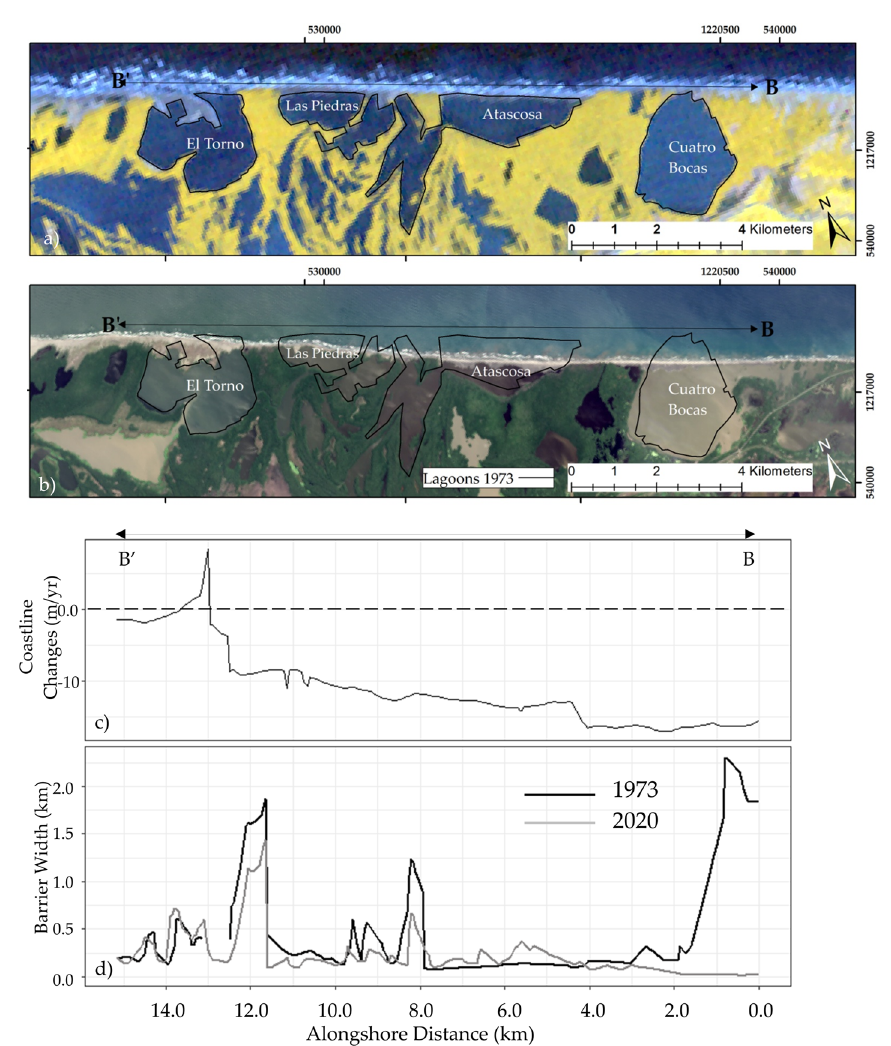
Figure 5. Barrier and lagoon evolution as observed on ( a ) January 2, 1973, and ( b ) February 17, 2020; ( c ) average rate of coastline changes for 1973, 1984, 2000, 2011, and 2020 and ( d ) barrier width for transect B-B’ in 1973 and 2020.